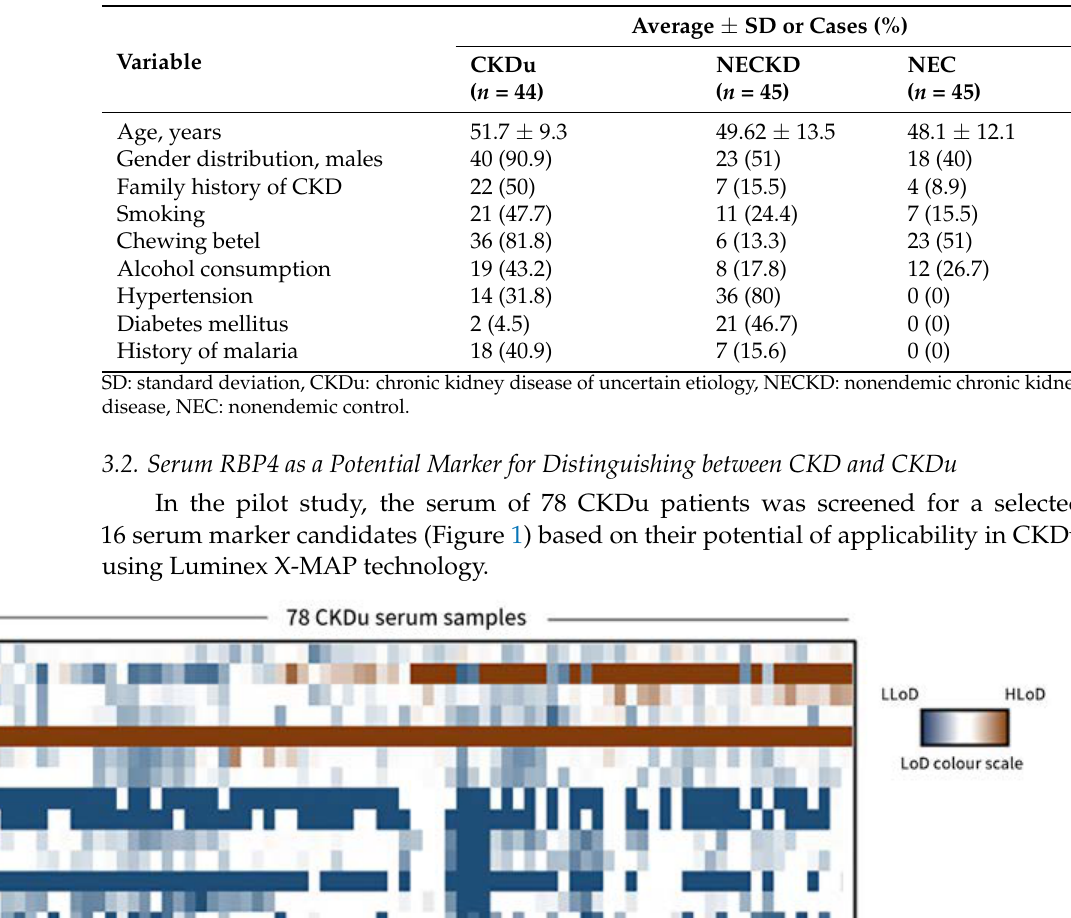
Table 1. Demographic and clinical characteristics of the study subjects.